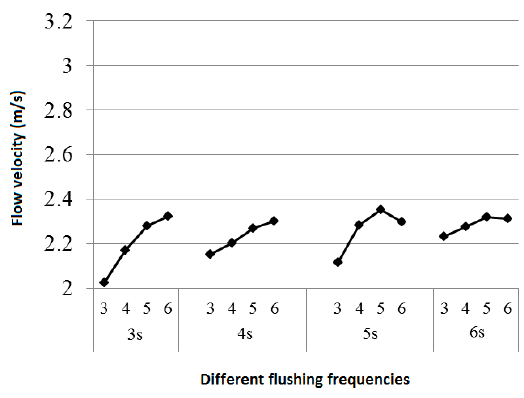
Figure 26. Flow velocity comparison of all the frequencies when the slot nozzle is on top of the pipe.